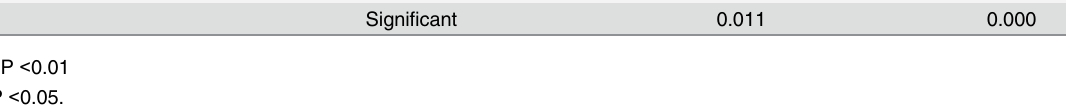
S1 Table. Data of AV-H, BCR, FAR and P_D in the 26 sub-districts from 2003 to 2012. (XLSX)